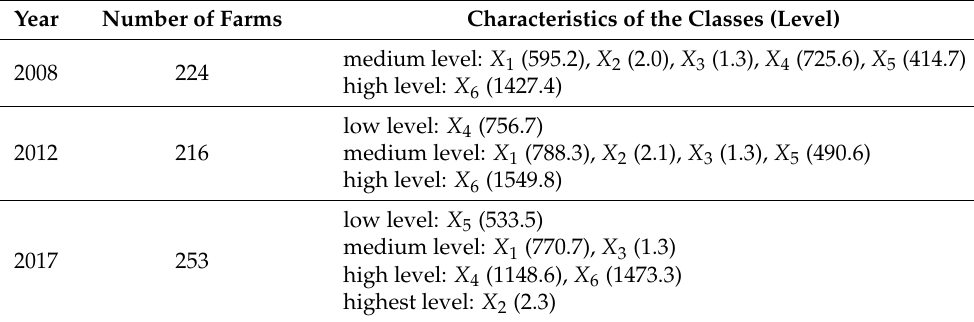
Table 4. Characteristics of farms in the type one group.